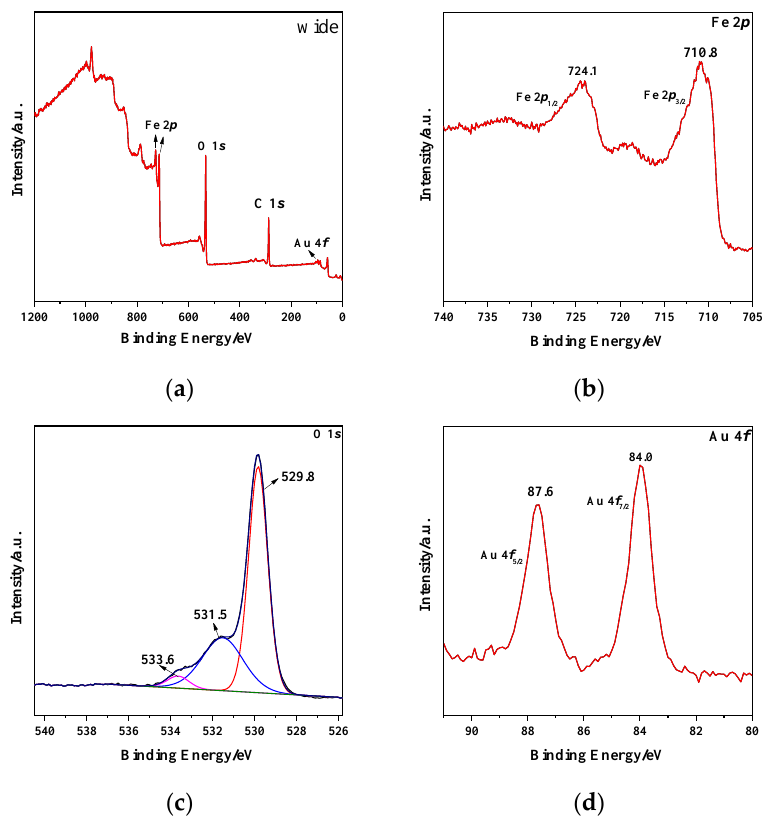
Figure 6. ( a ) The wide pattern, ( b ) Fe 2 p , ( c ) O 1 s , ( d ) Au 4 f XPS patterns of 1.86% Au/α-Fe 2 O 3 catalyst calcined at 300